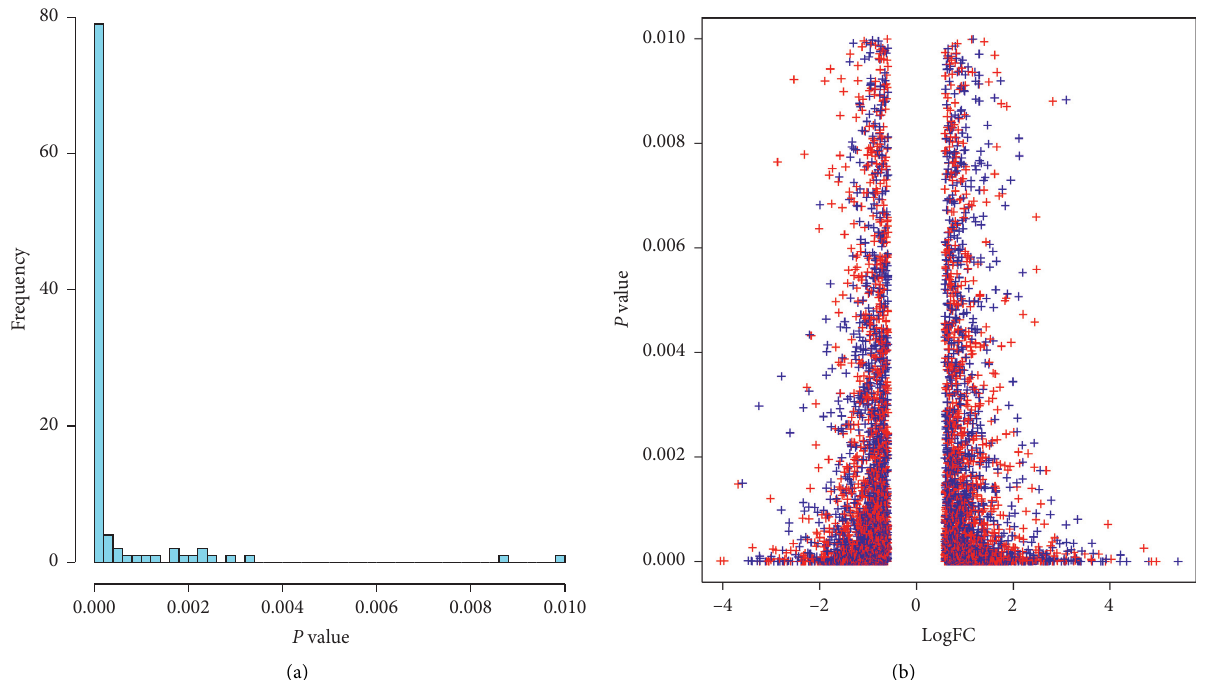
Figure 7: The genes number distribution of P < 0 . 01 and the correlation LogFC and P value.